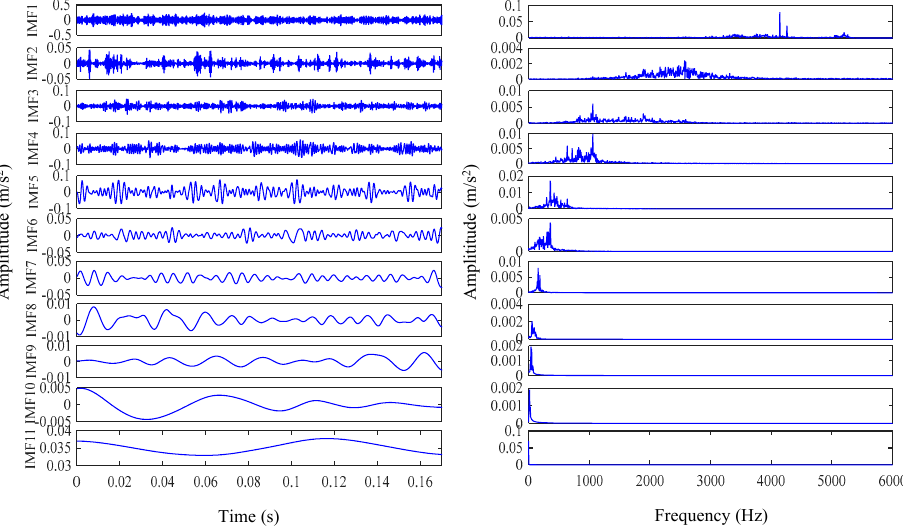
Figure 28. Time domain plot of challenging data 198FE and envelope spectrum.